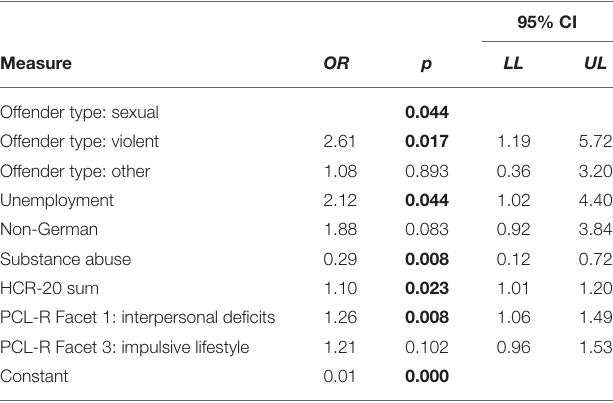
TABLE 6 | Logistic regression predicting treatment dropout–model with best fit after stepwise backward elimination per likelihood-ratio-test ( N = 202).